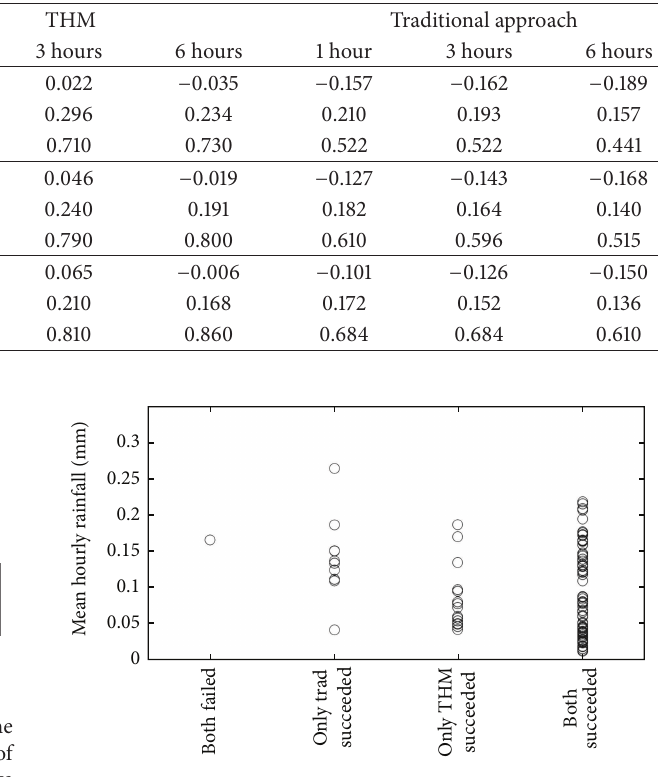
Figure 14: Relationship between the hourly rainfall mean and whether THM and traditional approaches succeeded in reproducing peak flow at the virtual watershed with curve number